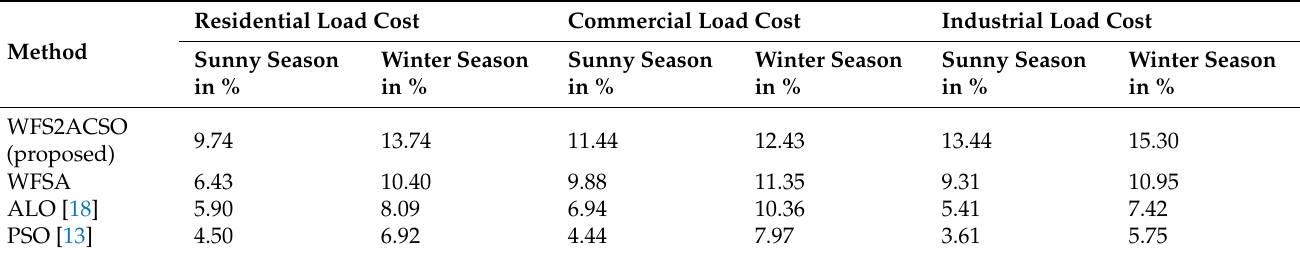
Table 9. Percentage reduction of operational cost comparison of various